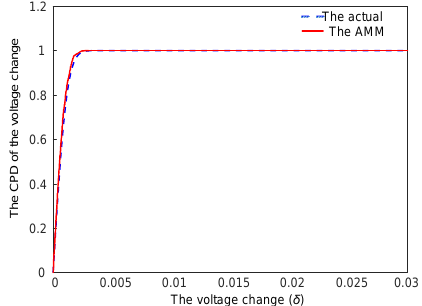
Figure 8. The CPD curve of the voltage change of node 23.